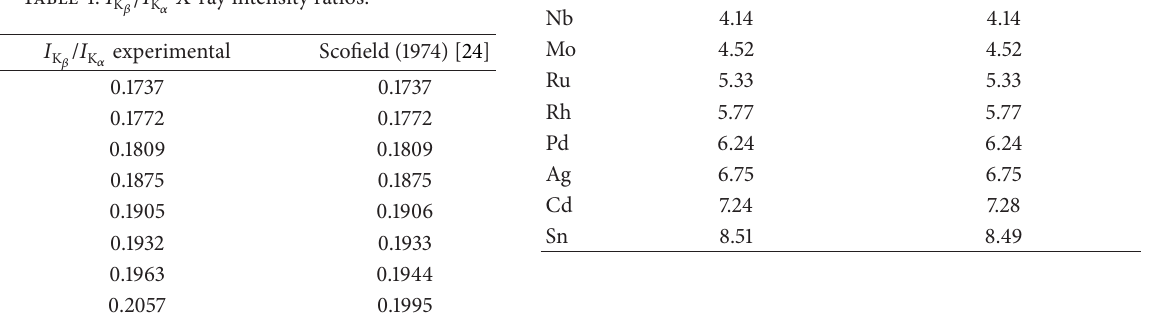
Figure 7: The variation in 𝜂 as a function of atomic number. KL /𝐼 X-ray intensity ratios. Table 4: 𝐼 K 𝛽 K 𝛼